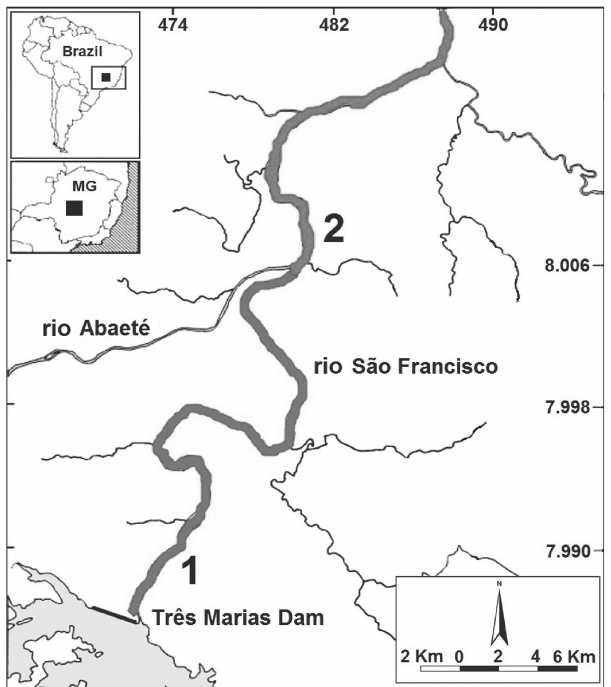
Fig. 1. Location of the study sites of the upper rio São Francisco, downstream from the Três Marias Dam, Minas Gerais State (MG), Brazil. Site 1, immediately downstream from the Três Marias Dam and site 2, below the confluence with the rio Abaeté.